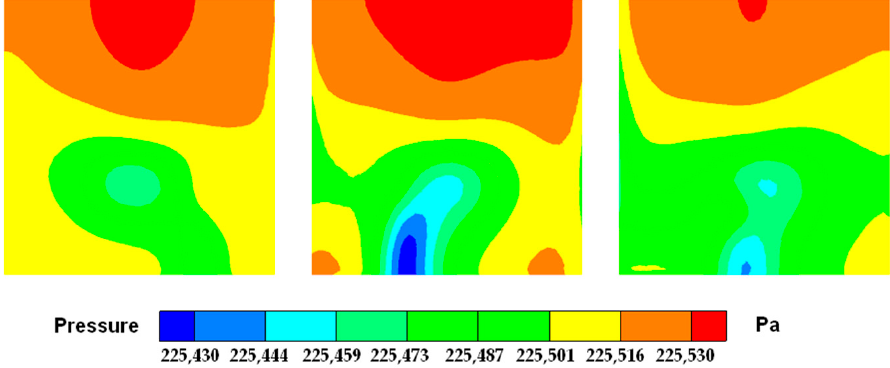
Figure 17. Contour map of inlet section pressure in scheme 1.